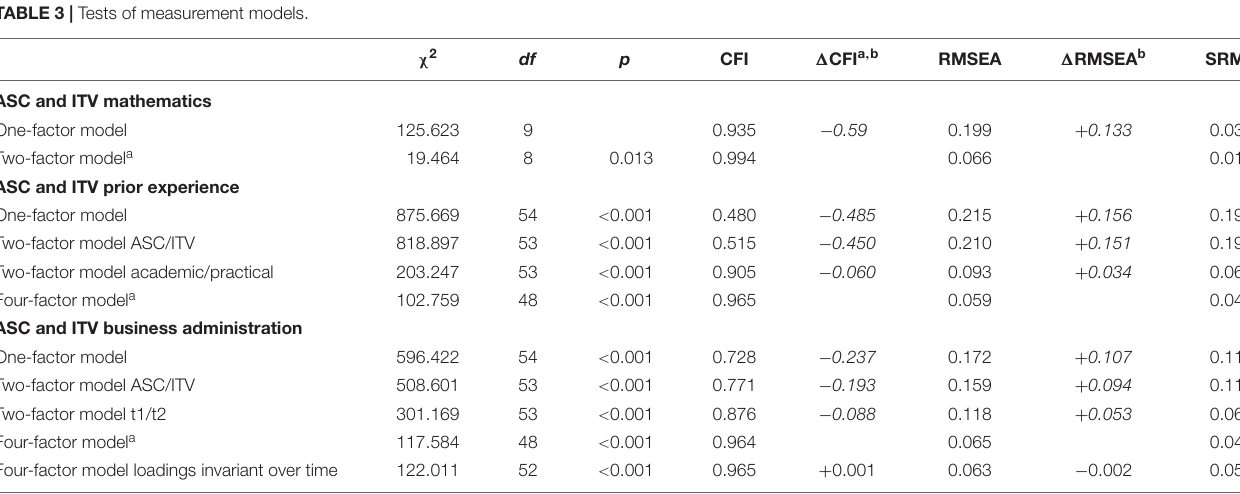
TABLE 3 | Tests of measurement